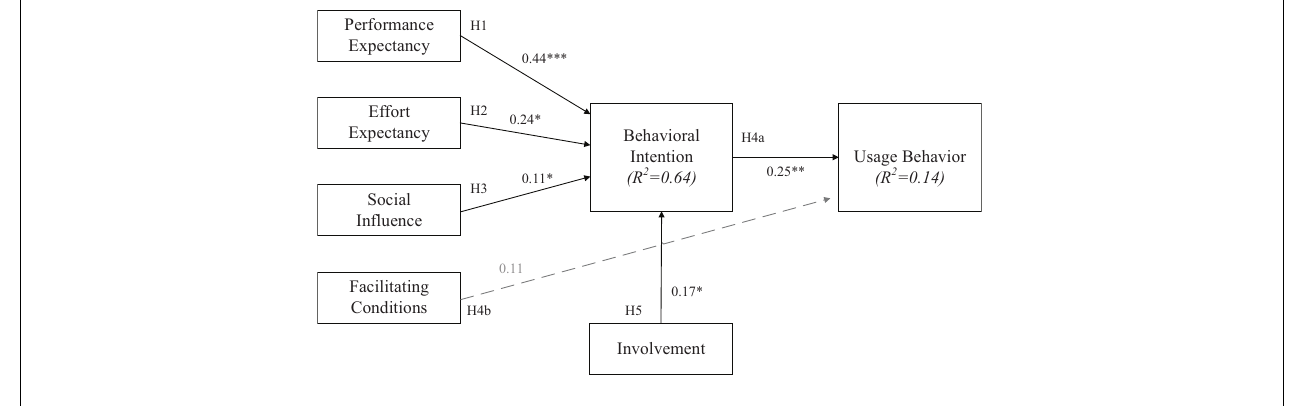
FIGURE 2 | Path coefficients of the structural model. * p < 0.05; ** p < 0.01; *** p < 0.001.